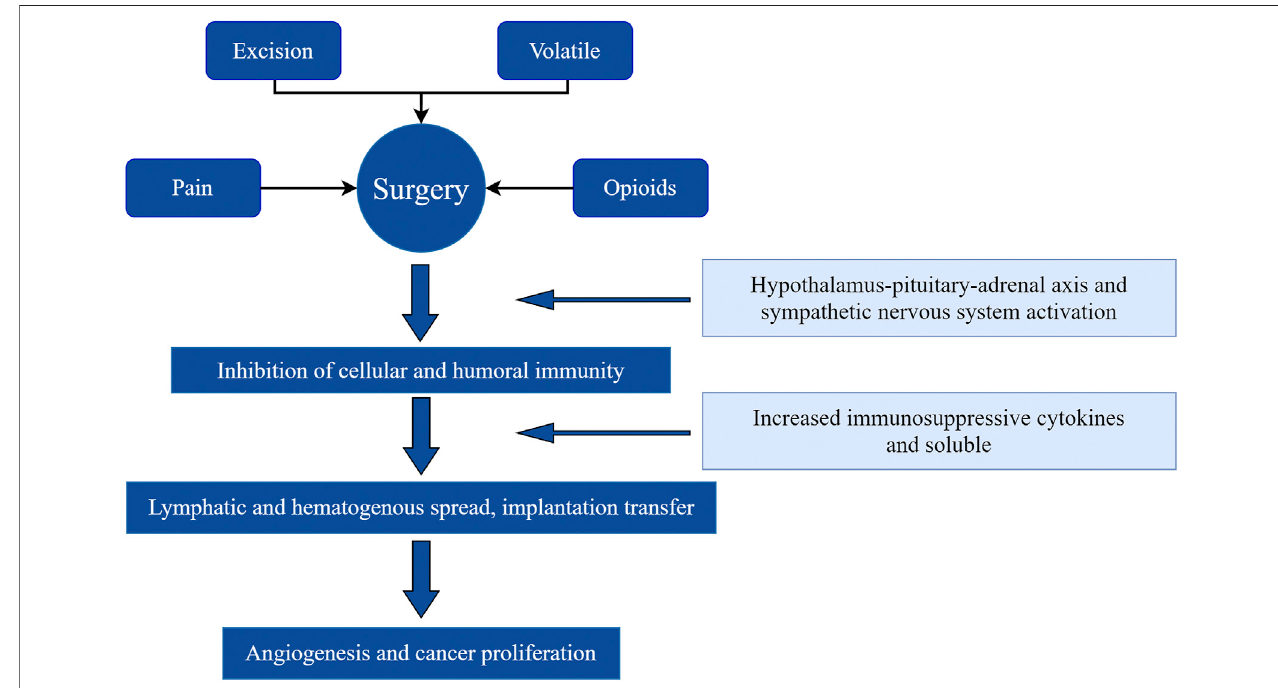
FIGURE 1 | Operative critical factors leading to angiogenesis and cancer cell